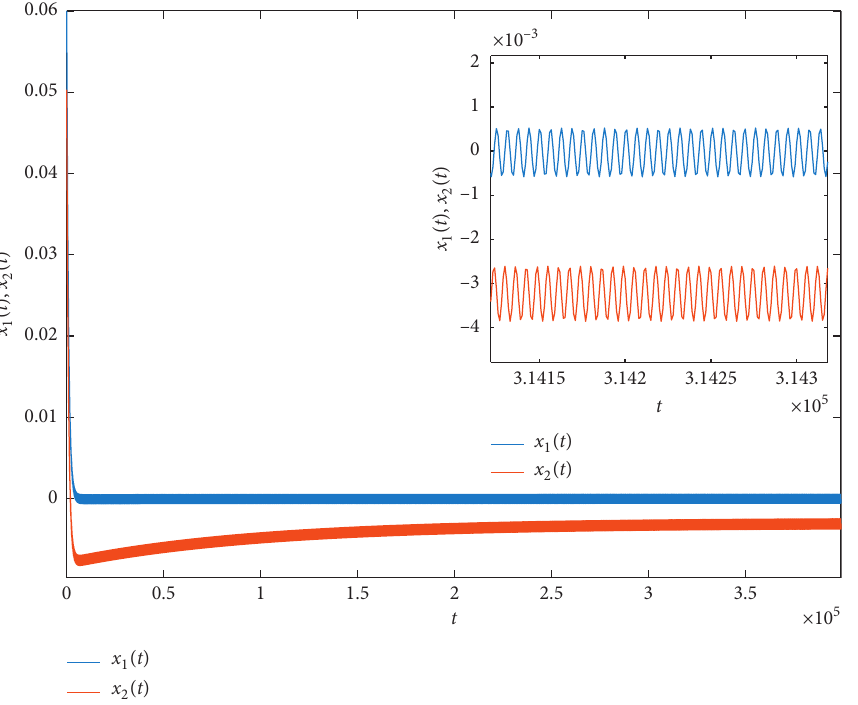
Figure 1: Time evolutions x